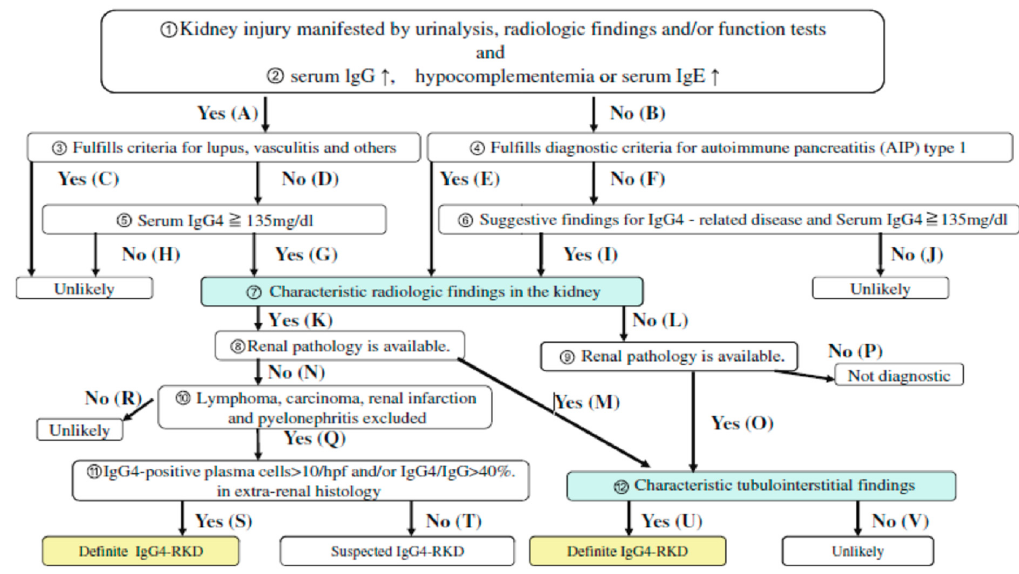
Figure 1. Diagnostic algorithm for IgG4-related kidney disease (IgG4-RKD) as proposed by Kawano et al. (with permission) [14].